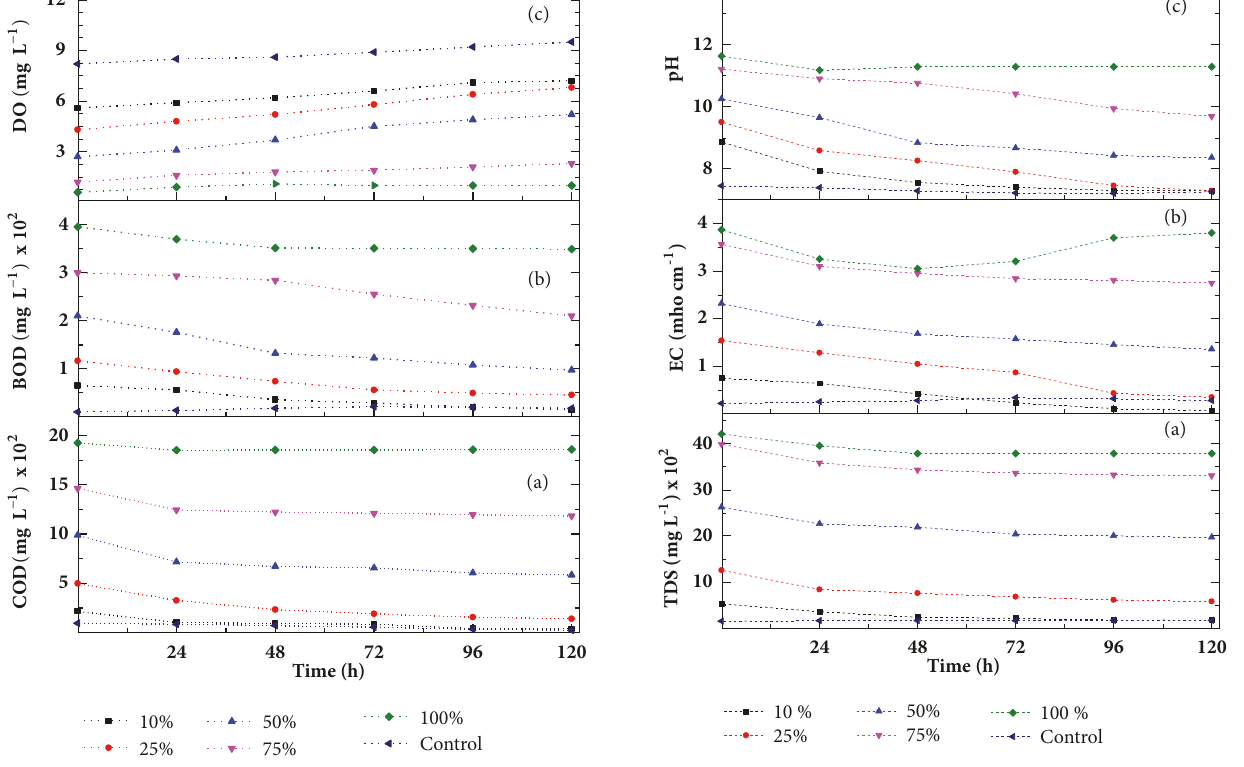
Figure 2: Variation in COD (a), BOD (b), and DO (c) as a function of time at different concentration.